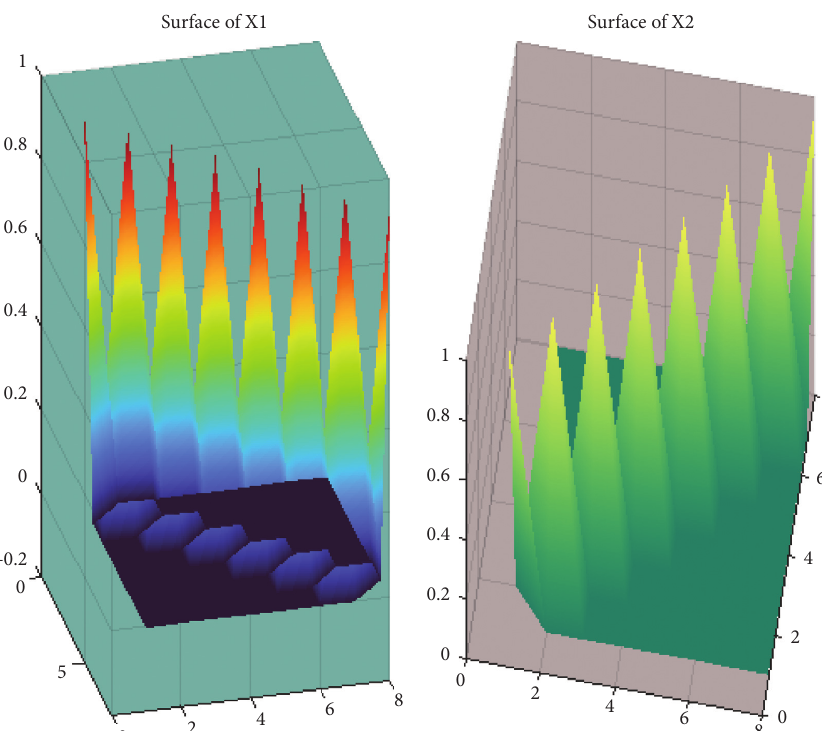
Figure 13: Solution surface plot for dimension